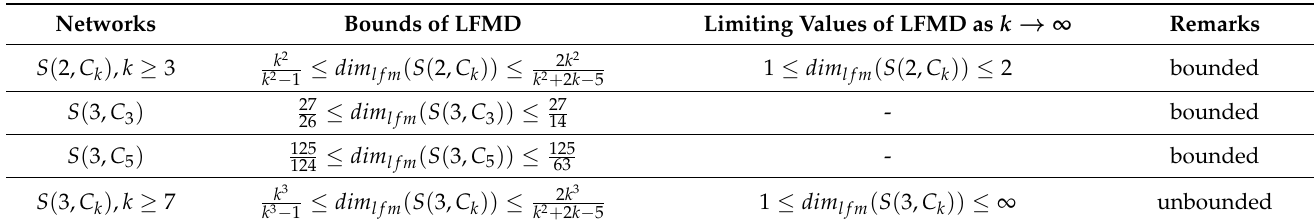
Table 5. Boundness of LFMD of Sierpinski network S ( 2, C k )